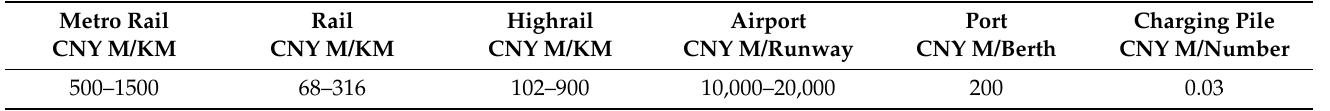
Table A3. Scope of the investment costs of infrastructure in 2020 (CNY million).